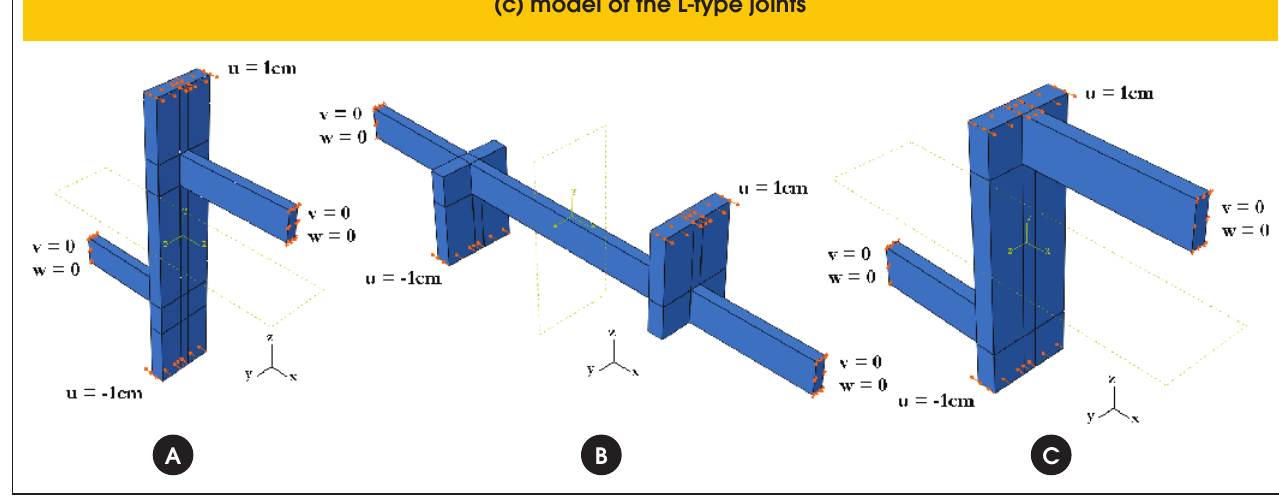
(c) model of the L-type